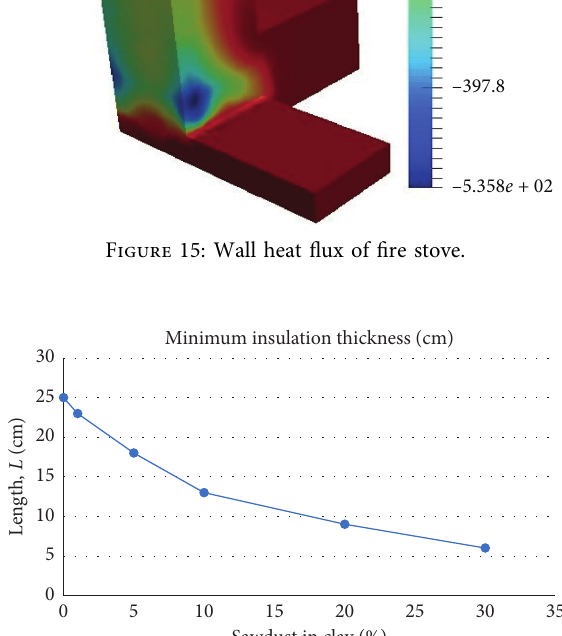
Figure 16: Influence of sawdust on the thickness of the